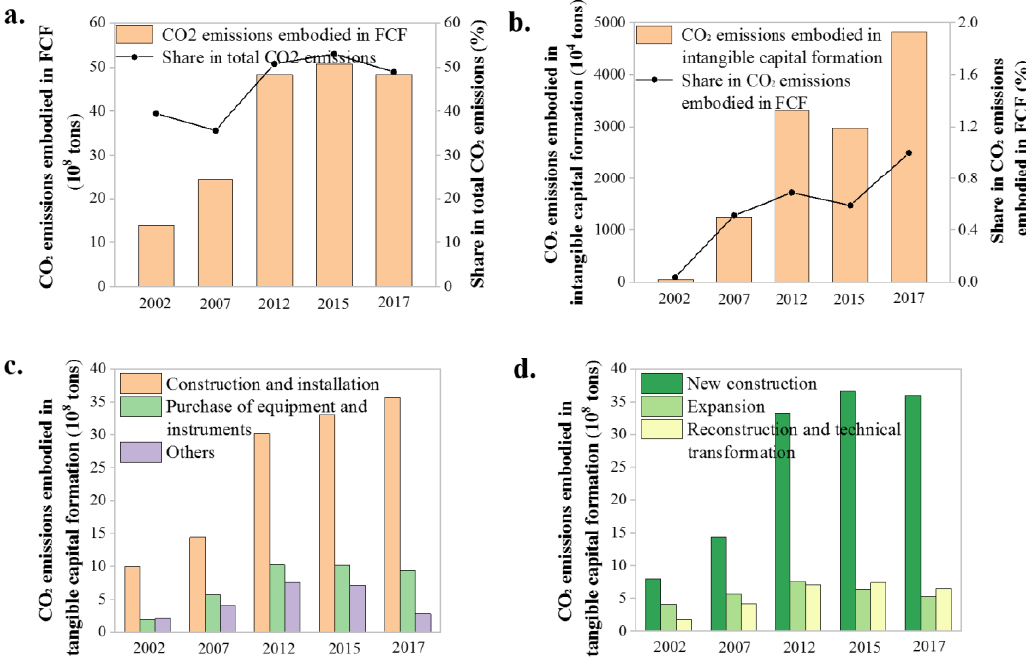
Figure 2. Trends of CO 2 emissions embodied in fixed capital formation (FCF) and its compositions in China.